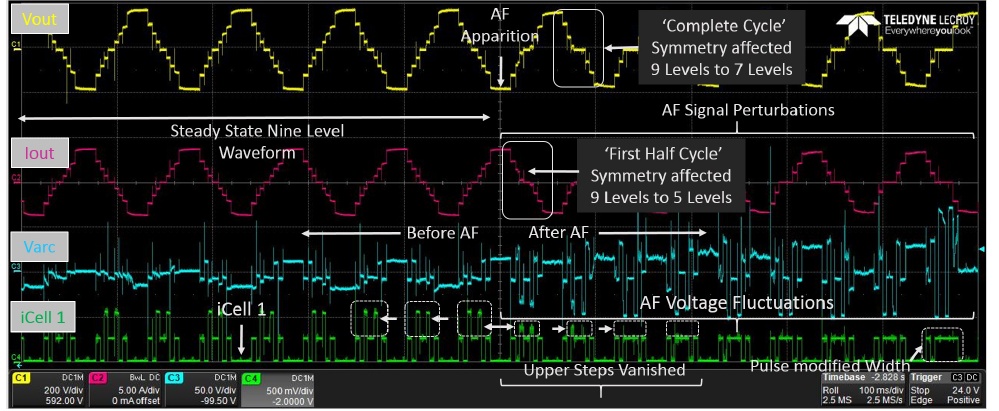
Figure 13. DC/AC cascade cells’ configuration for AF testing.